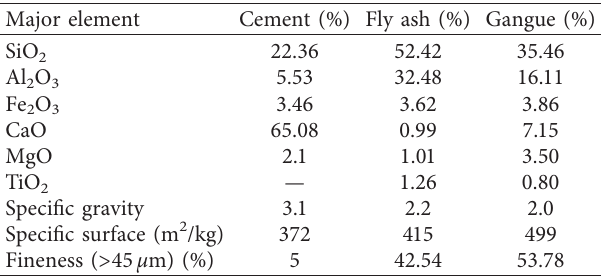
Table 1: Chemical and physical properties of the main raw ma- terials of CGBM [4].